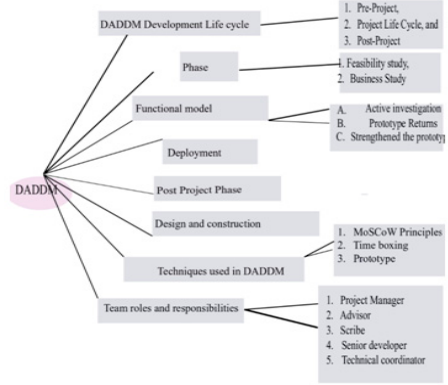
Figure 4. Complete operation of the proposed model DADDM.